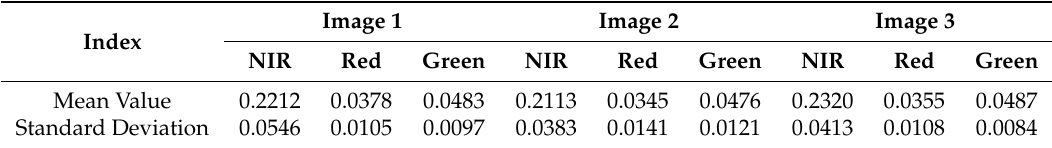
Table 1. Mean and standard deviation in three bands of a multi-band